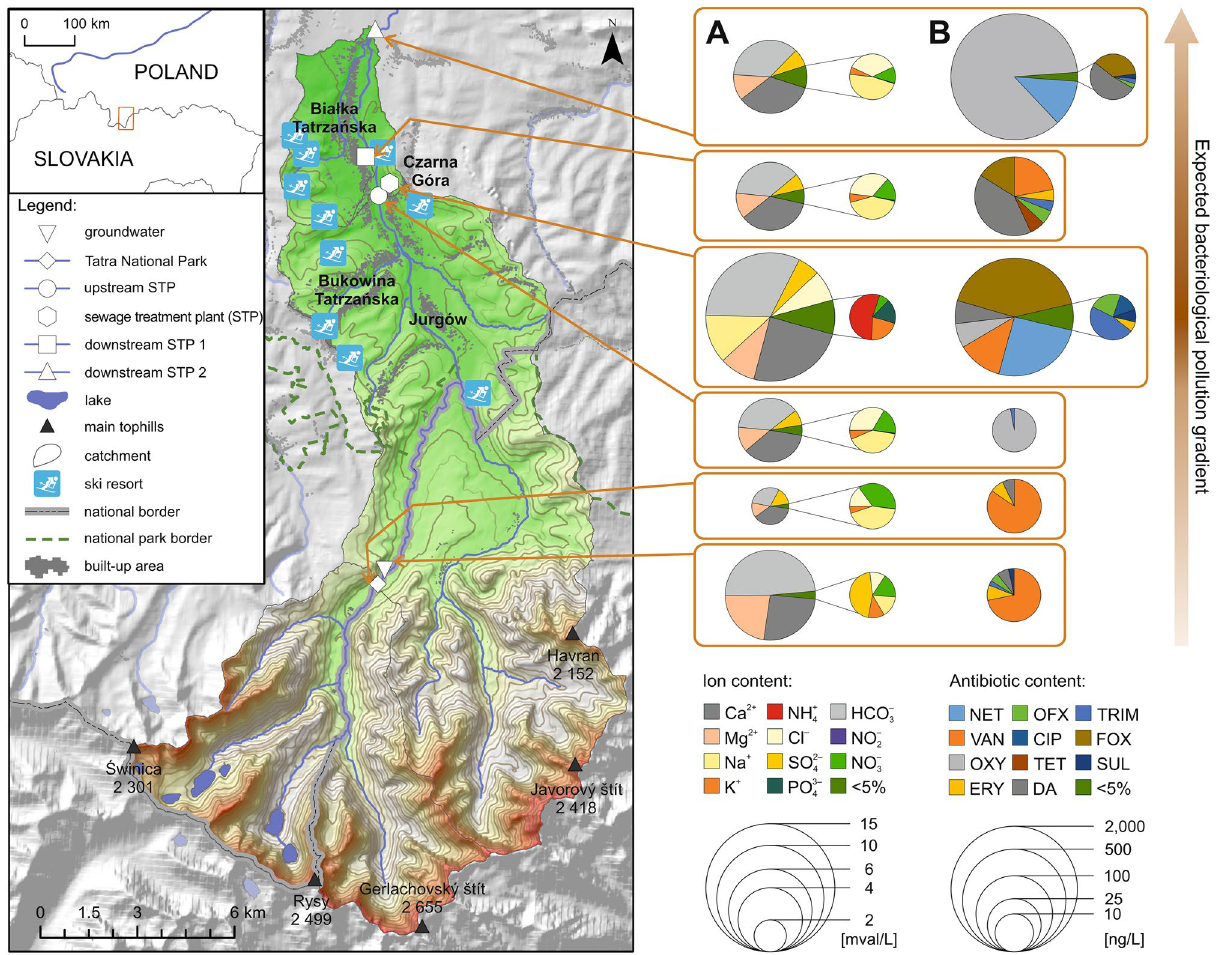
Figure 2. Study area and sampling sites along the Białka river. The 1st site is located at the border of the Tatra National Park (TNP) and is characterized by the cleanest waters. The 2nd site is situated c.a. 1 km upstream of the sewage treatment plant (USTP) of the Bukowina Tatrzańska municipality. The 3rd site is located by the effluent from the Bukowina Tatrzańska sewage treatment plant (STP). The 4th site is situated approximately 3 km downstream of the STP discharge, in the center of Białka Tatrzańska ski resort (DSTP1), and the 5th site— approximately 7 km downstream of the STP discharge in the Trybsz village (DSTP2). Groundwater collected in the Tatra National Park was treated as control, i.e. the most pristine water (GW) 3 . Pie chart graphs to the right show color coded ion ( A ) and antibiotic ( B ) content detected in particular sites during all three sampling dates. The size of the primary charts is logarithmically scaled (see the scales to the bottom right), the secondary charts have not been content-scaled. Please note significantly increased ion and antibiotic content in the Białka river after passing the STP site. Arrow graphs show the expected bacterial pollution gradient, darker brown shade indicates the more contaminated sites, the arrowhead indicates the course of Białka